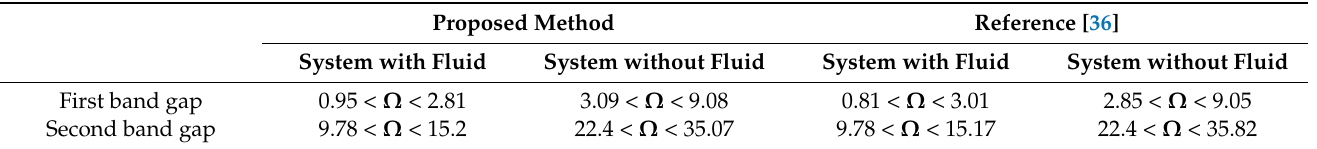
Table 1. Locations of band gaps of the periodic plate from